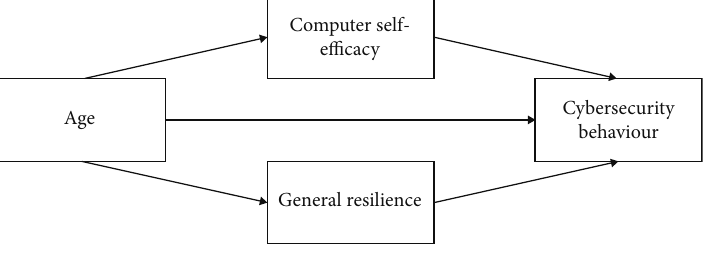
Figure 1: Parallel mediation model (PROCESS model 4). Table 4: Parallel mediation analysis for each of the cybersecurity behaviours. Signi fi cant paths are indicated with an asterisk ( ∗